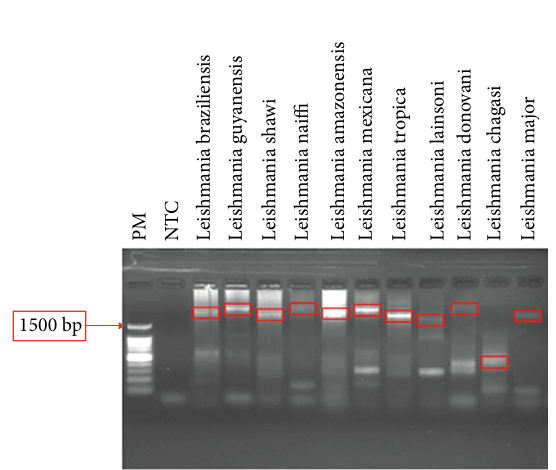
Figure 2: Agarose gel (1.0%) showing PCR reaction result for IGS rRNA region ampli fi cation of di ff erent Leishmania spp. IGS — Intergenic Spacer; rRNA — ribosomal RNA; bp — base pairs; PM — marker 100bp (Promega); NTC — nontemplate control. Boxes show bands extracted for puri fi